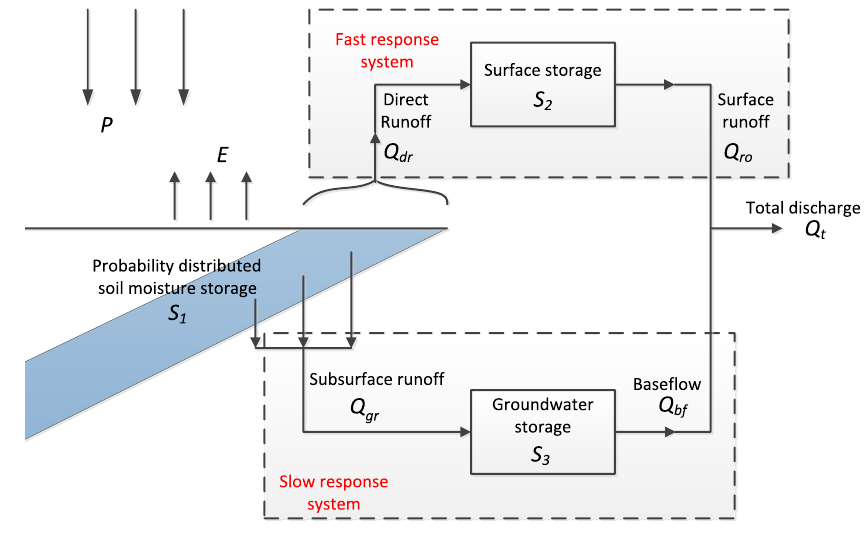
Figure 1. General model structure of the PDM (adapted from Moore, 2007).